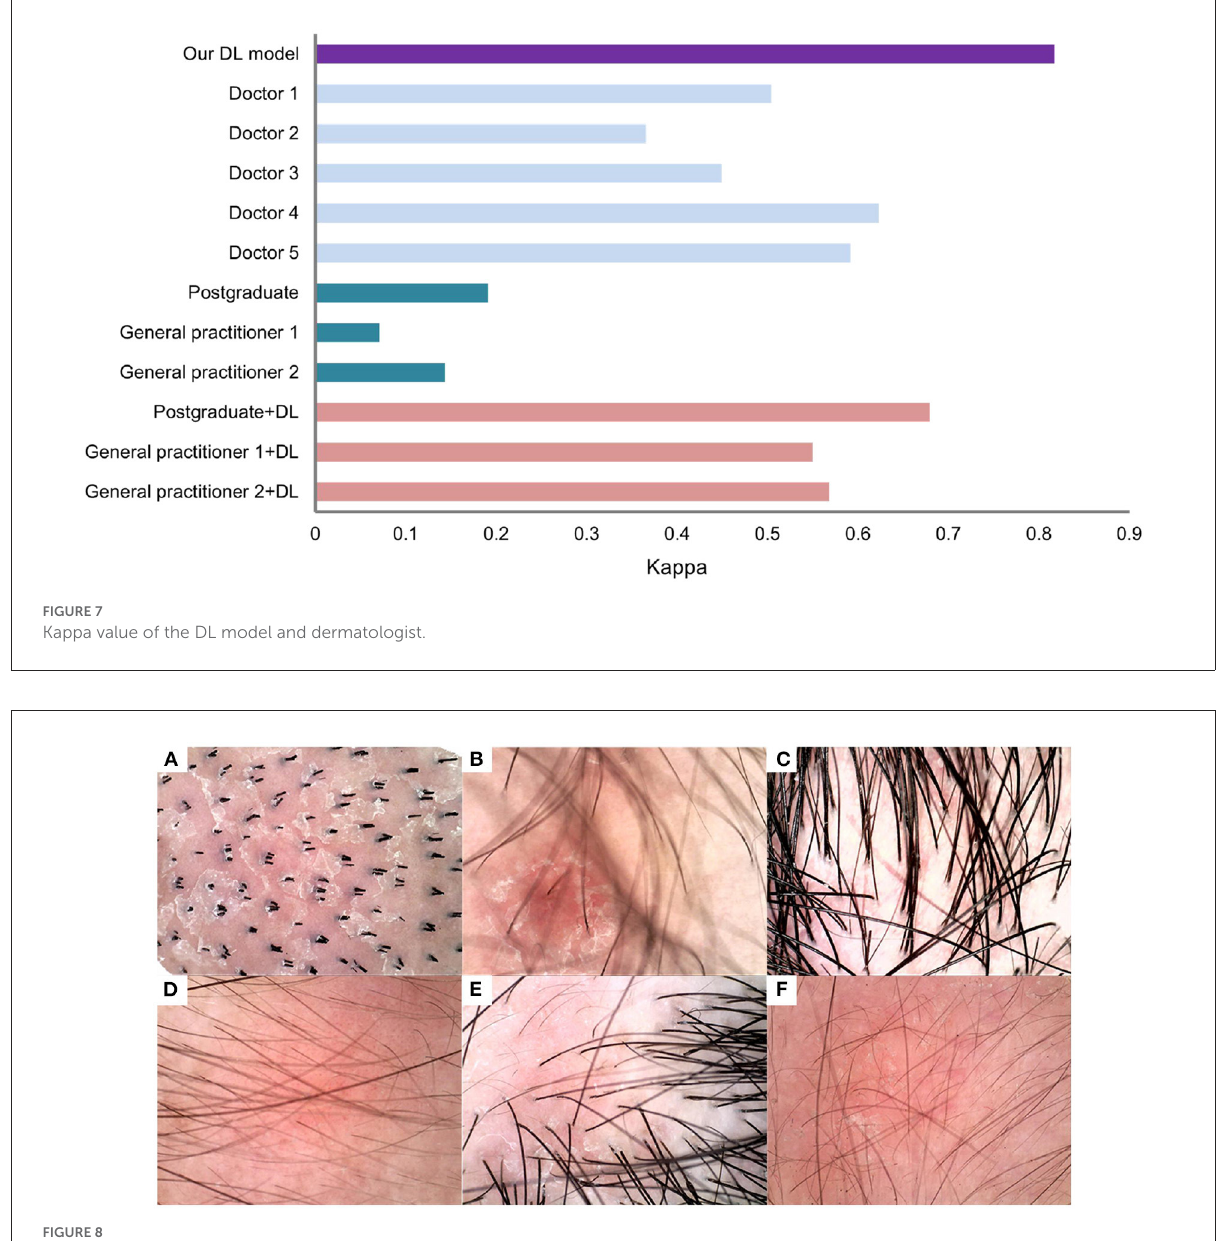
FIGURE8 Diagnosis results of DL model and humans (five physicians) on some indistinguishable lesion images. The below figures are represented in ground truth disease type and correctly diagnosis rate of humans: (A) seborrheic dermatitis, 40%, (B) seborrheic dermatitis, 60%, (C) seborrheic dermatitis, 0%, (D) psoriasis, 20%, (E) psoriasis, 40%, and (F) psoriasis, 40%. For comparison, the DL model correctly diagnosed all six